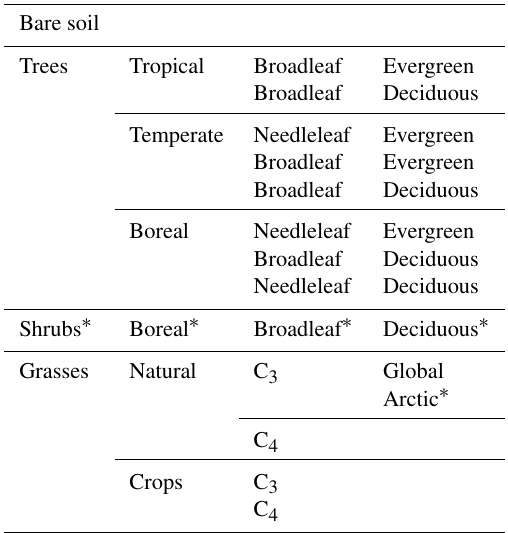
Boreal Needleleaf